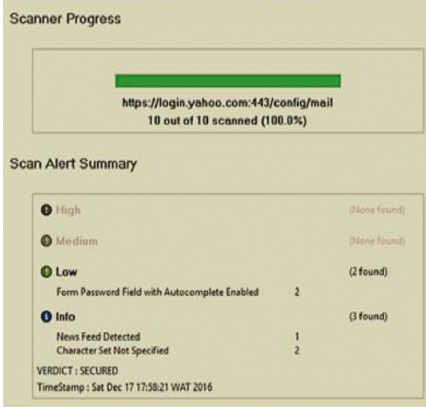
Figure 5: Scanner progress.